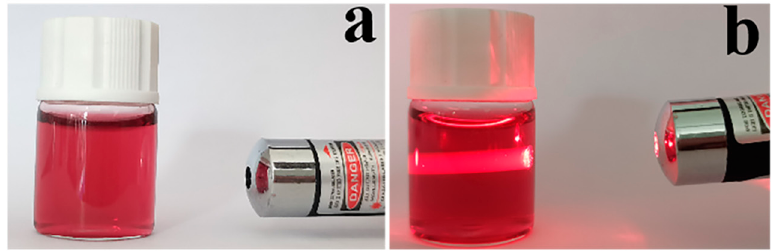
Figure 6. ( a ) Image of the gold nanoparticle solution; ( b ) Tindal effect